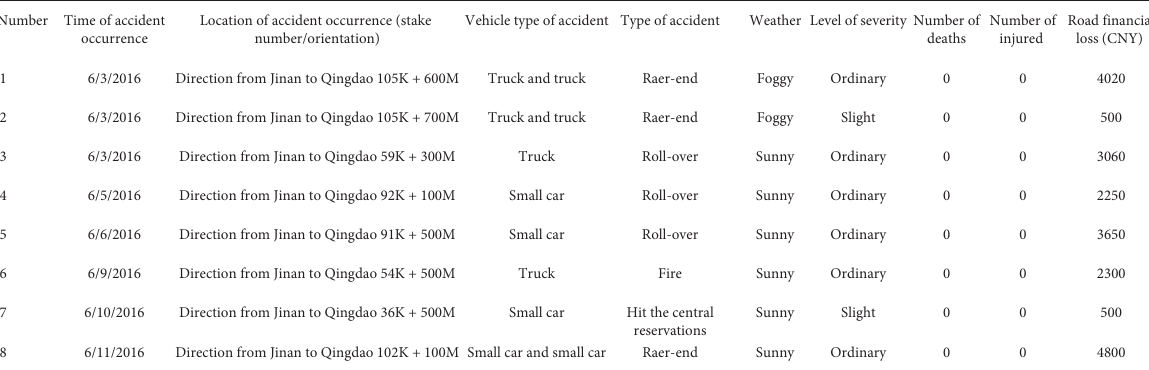
Figure 7: Chart of historical traffic accident data (partial translation